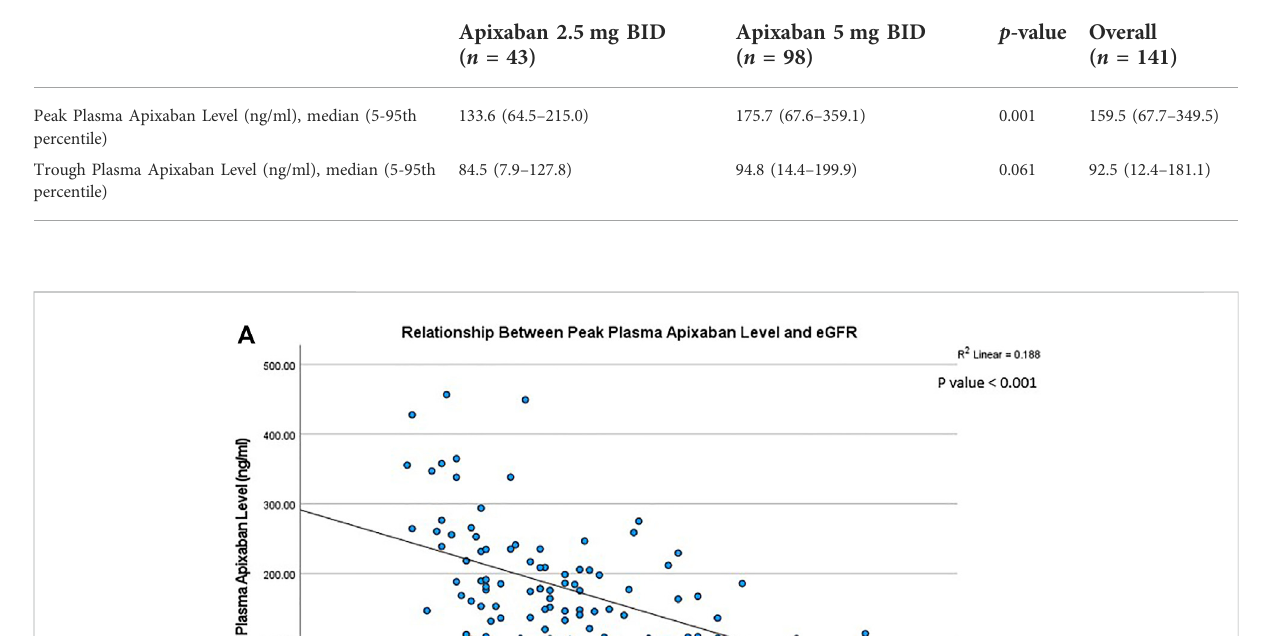
TABLE 2 Peak and trough apixaban level in patients receiving different dosage of